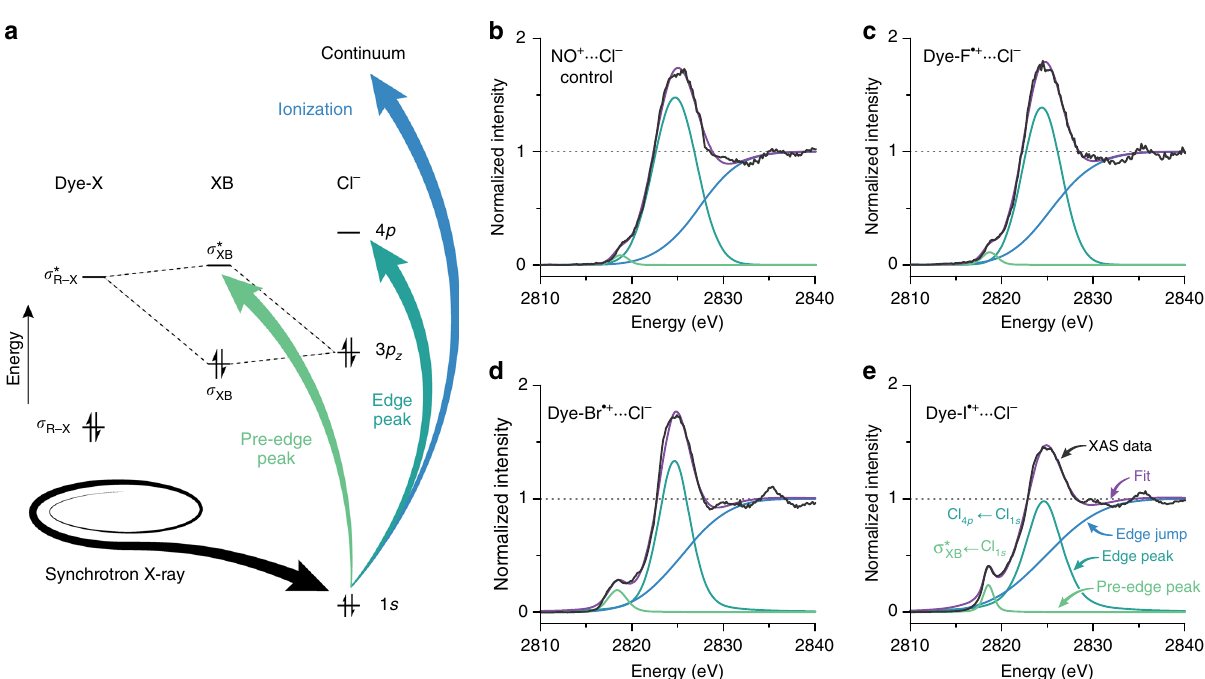
Fig. 2 Chlorine K-edge XAS spectra of the Dye-X series. a Schematic of molecular orbitals involved in halogen bonding and allowed transitions upon excitation of the Cl 1s electron by synchrotron X-ray radiation. b – e Chlorine K-edge X-ray absorption spectroscopy (XAS) spectra of the Dye-X ··· Cl − series. Spectra were modeled with BlueprintXAS peak fi tting analysis and the resulting components of each fi t are shown with each